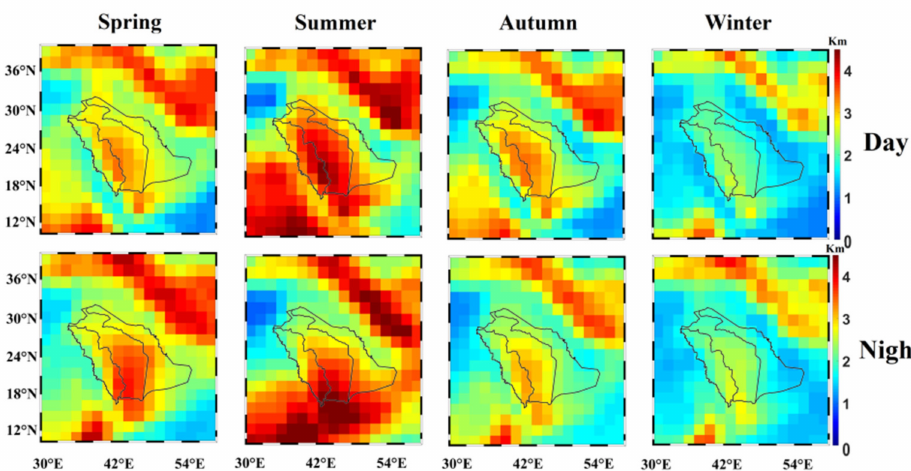
Figure 6. Seasonal spatial distributions of HB 1 over Saudi Arabia from 2007 to 2019.